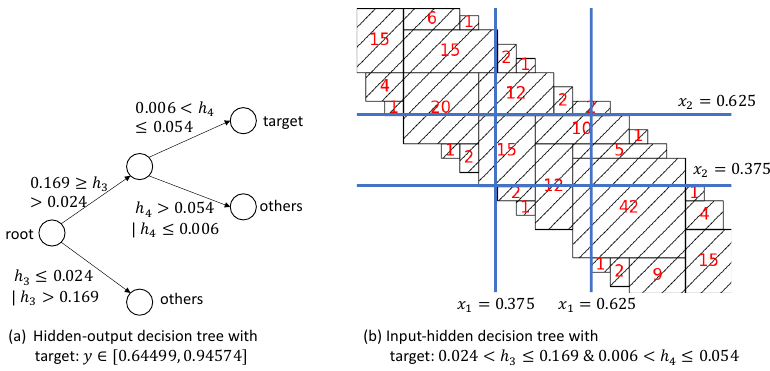
Figure 13. Decision trees for the target y ∈ [ 0.37642,0.62568 ]